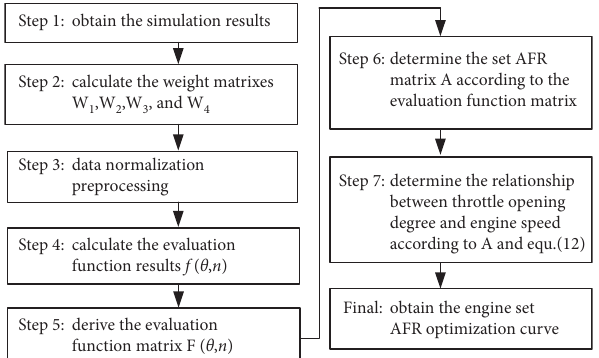
Figure 16: Optimization process.